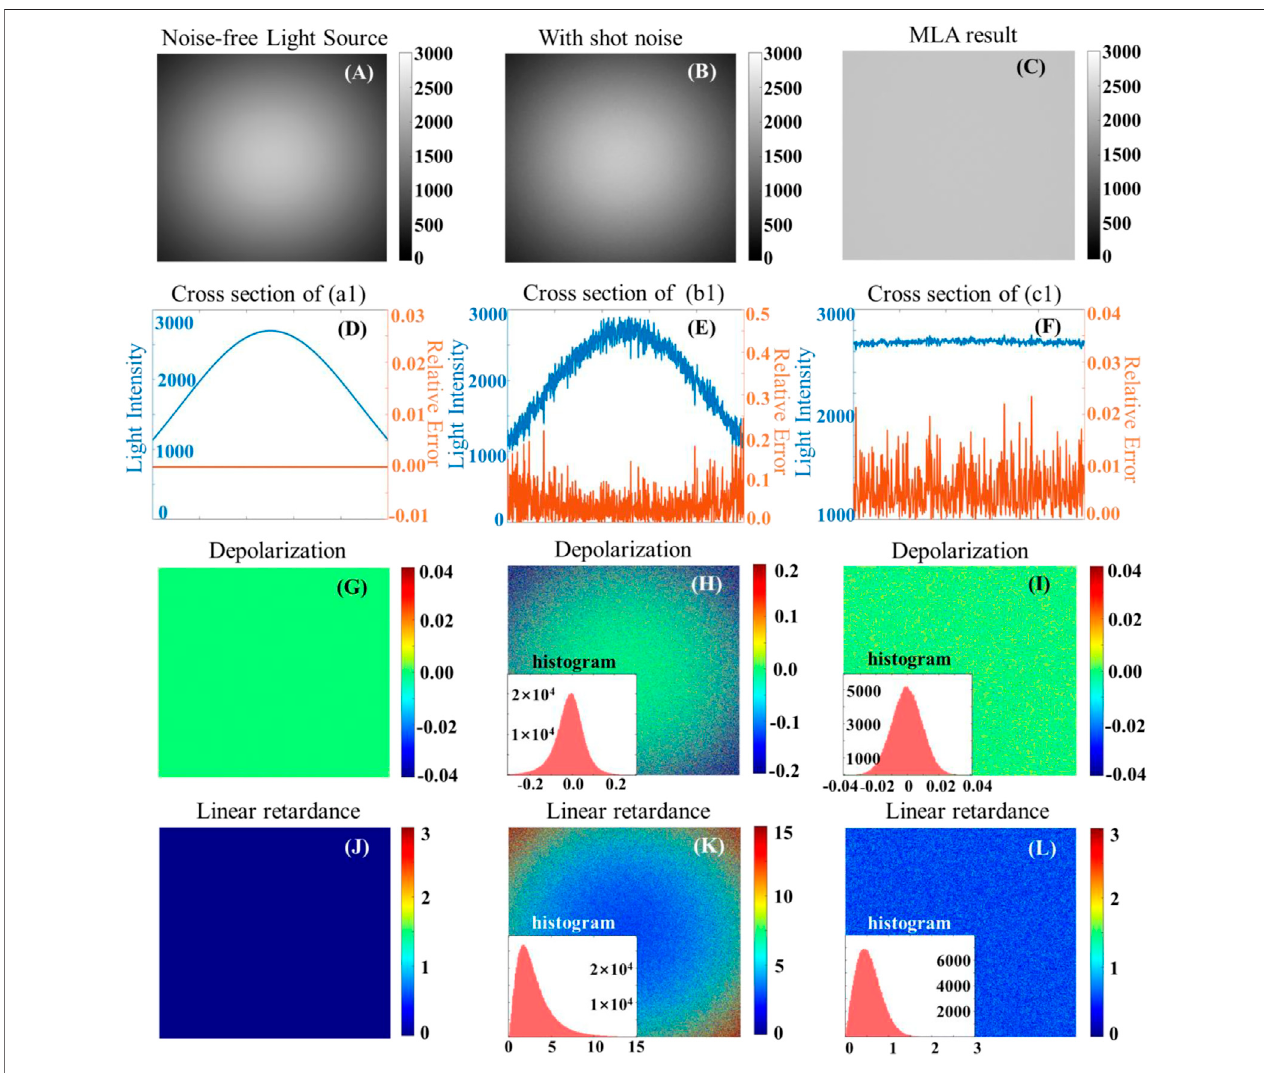
FIGURE 4 | (A) , (B) , and (C) : three typical cases for the fi rst light intensity image; (D) , (E) , and (F) : the cross-section of light intensity (blue curve) and relative error (orange curve) corresponding to (G) -(I) and (J) -(L) are the calculated depolarization and linear retardance results for the three typical cases, respectively.